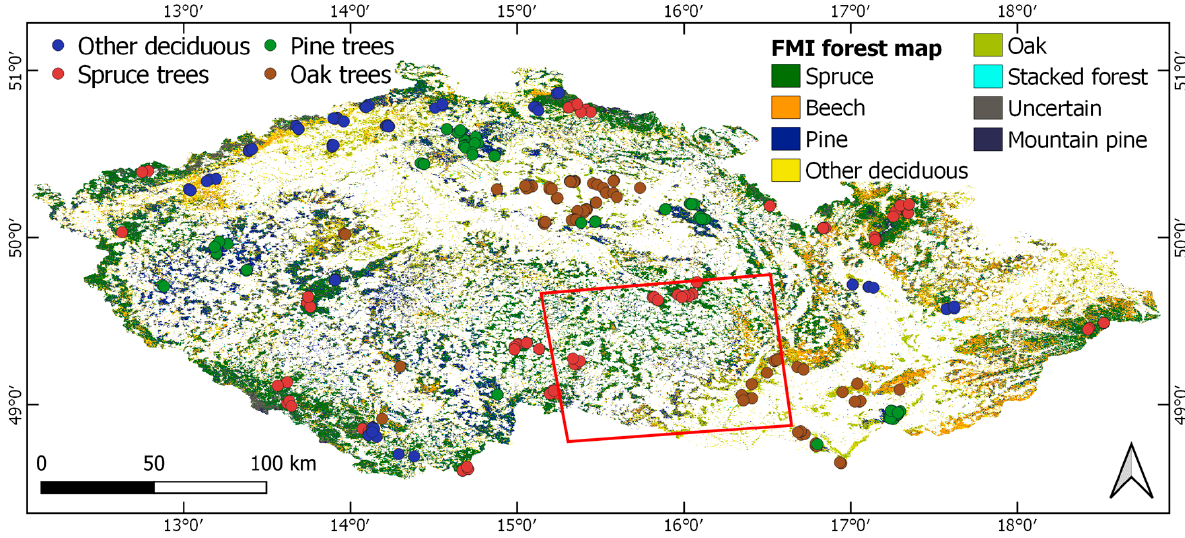
Figure 5. Overview of the performed sensitivity test: red polygon outlines the test site and dots indicate the locations of signature prototypes. The base map is the forest map from the Czech Forest Management Institute (FMI) that was used for the selection of the signature prototypes’ location.